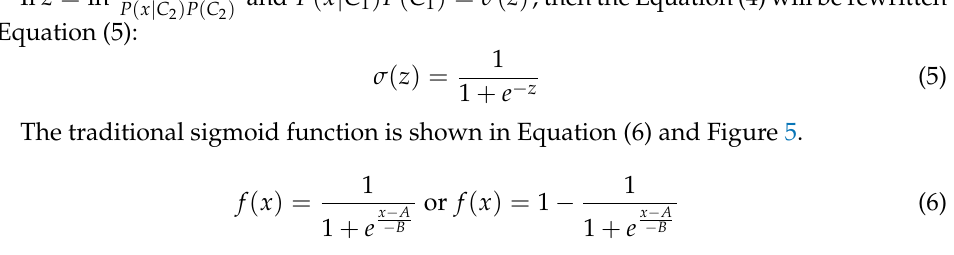
region is similar to the inhibited state of neurons. Therefore, in terms of neural network the bilateral the bilateral regions.